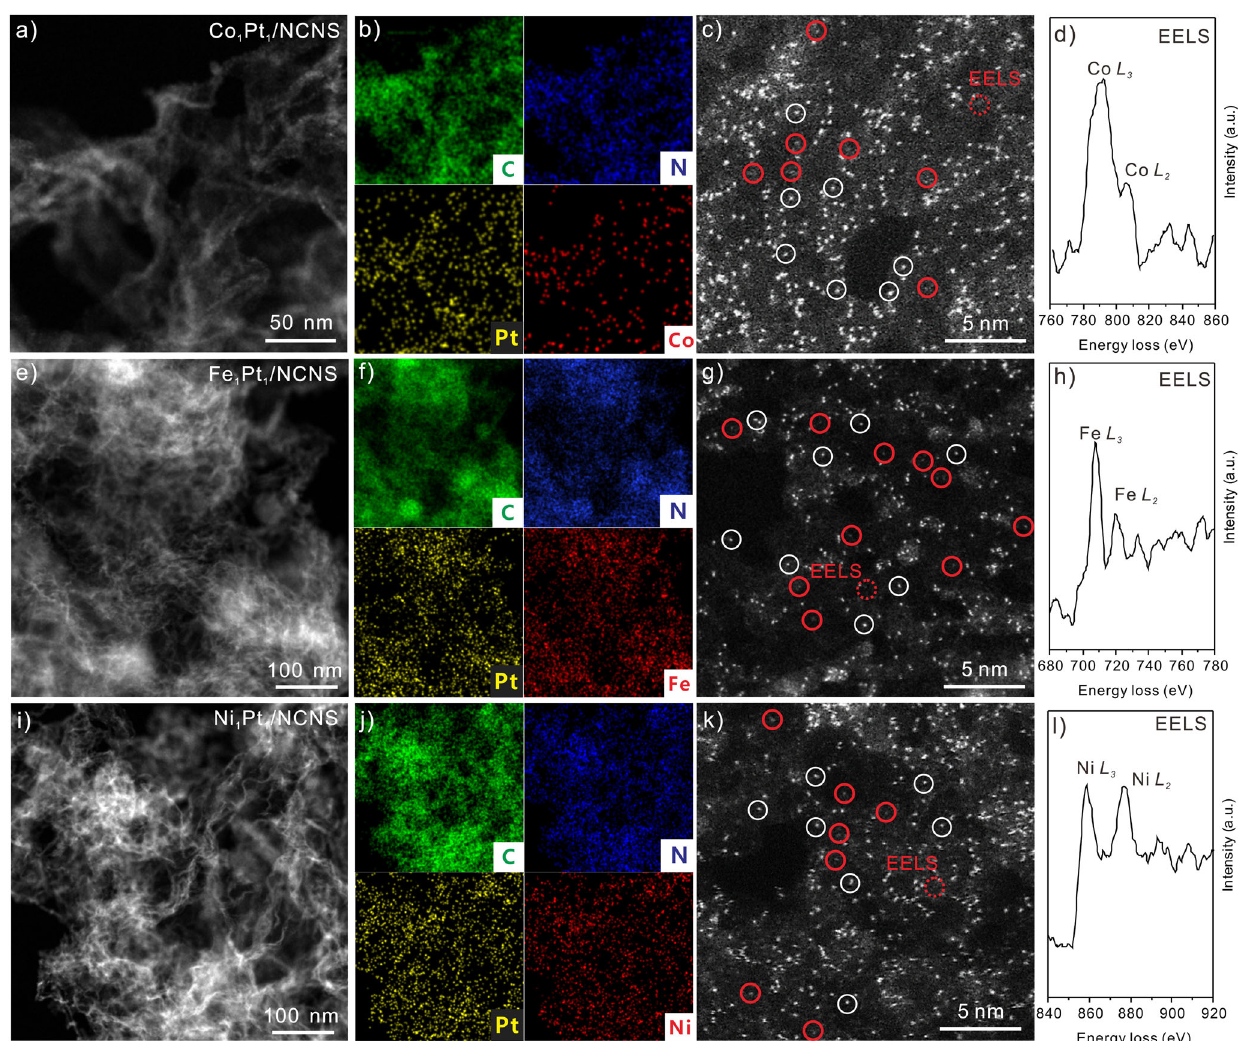
Fig. 3 Morphology of M 1 Pt 1 /NCNS catalysts. HAADF-STEM images of Co 1 Pt 1 /NCNS ( a ), Fe 1 Pt 1 /NCNS ( e ), and Ni 1 Pt 1 /NCNS ( i ) at low resolution and corresponding EDX mapping ( b , f , and j ). HAADF-STEM images on Co 1 Pt 1 /NCNS ( c ), Fe 1 Pt 1 /NCNS ( g ), and Ni 1 Pt 1 /NCNS ( k ) samples. The white circles highlight the Pt single atoms. The red circles highlight the Co, Fe, and Ni single atoms, respectively. d , h , and l Corresponding EELS spectra at the location of red dash circle in c , g , and k